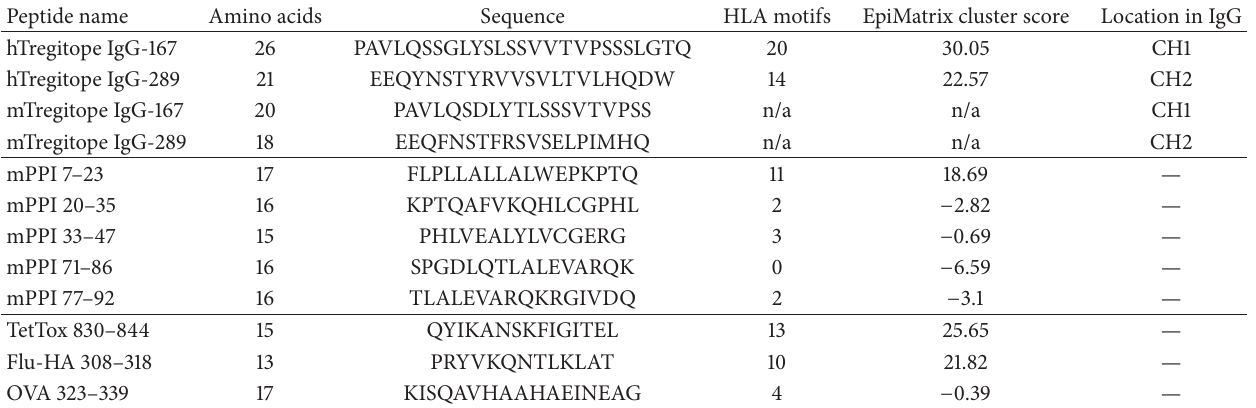
Table 2: Treatment and control peptides for in vitro and in vivo studies. The following table contains information on the sequences, MHC promiscuity, and parental protein location of the peptides and controls used in these